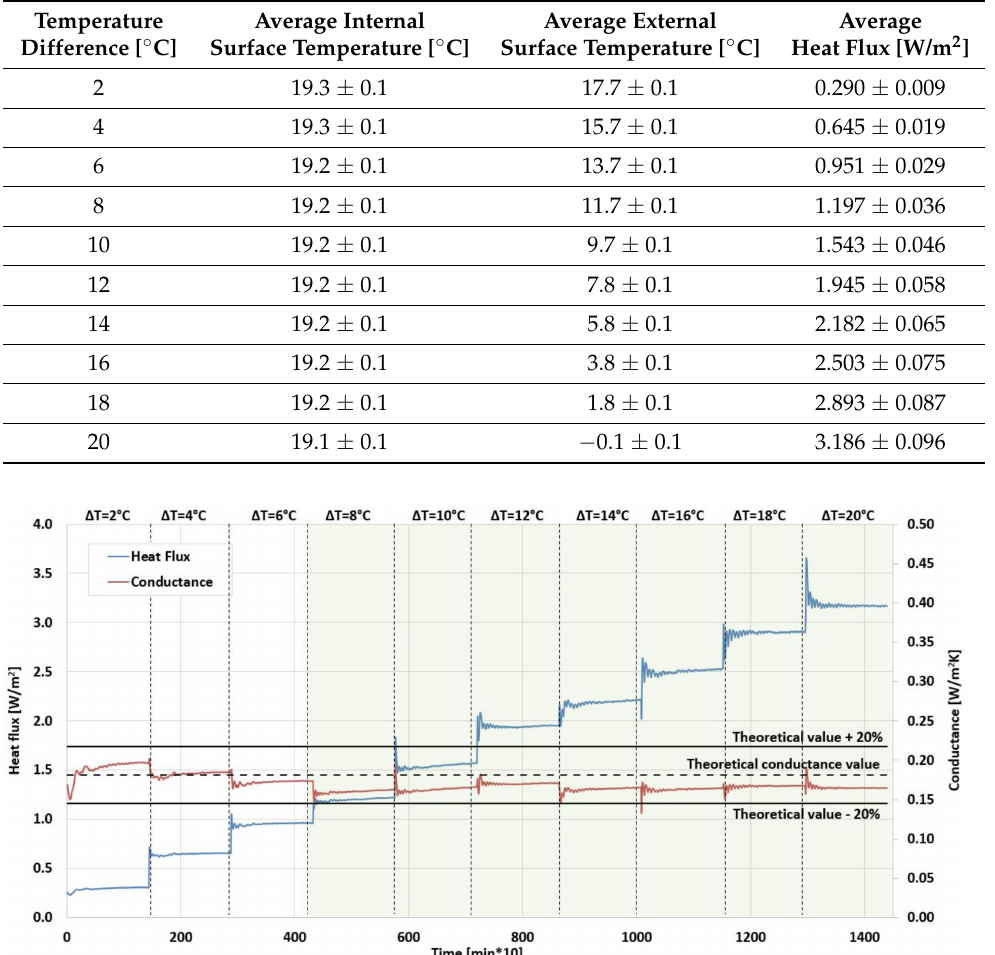
Figure 3. Average heat flux and thermal conductance obtained during the tests (the acquired data were processed within a graph showing only the last 24 h of measurement for each temperature